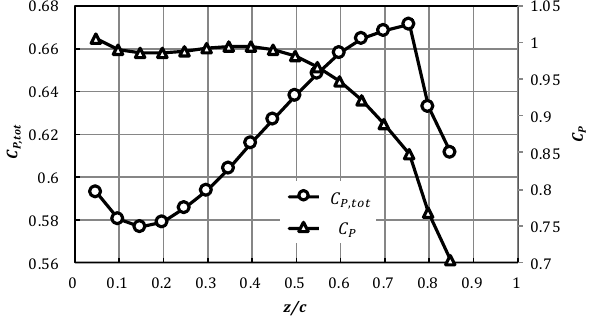
Figure 12. Variation of C P , total with z/c ( C T , rotor = 0 . 927; α = 26 . 2 ◦ ; and (cid:49)r/D = 0 .